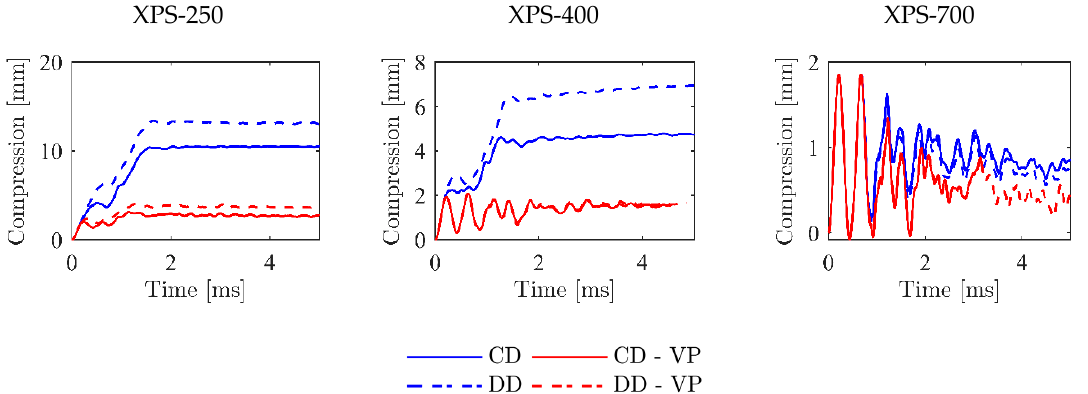
Figure A6. Core compression from simulations of tests at 12 bar firing pressure.